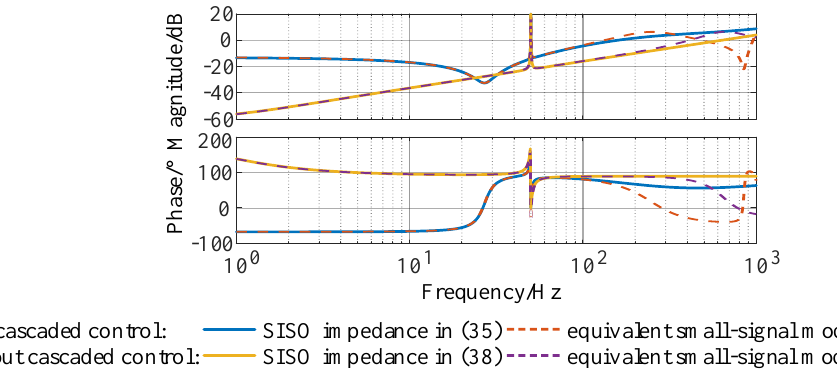
Figure 5. Impedance characteristics of VSG controlled converters.